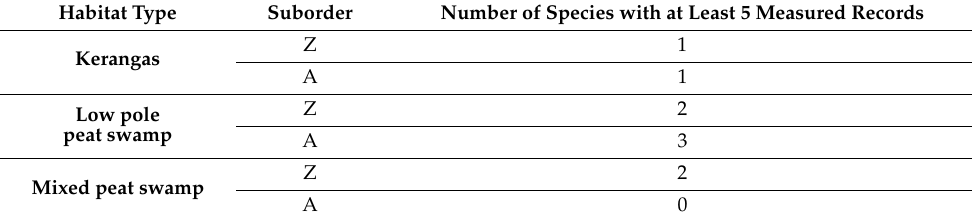
Table A1. The rationale behind as to why it was not possible to include species as random effect due to small sample sizes recorded across all habitat types: Kerangas (heath), low pole peat swamp, and mixed peat